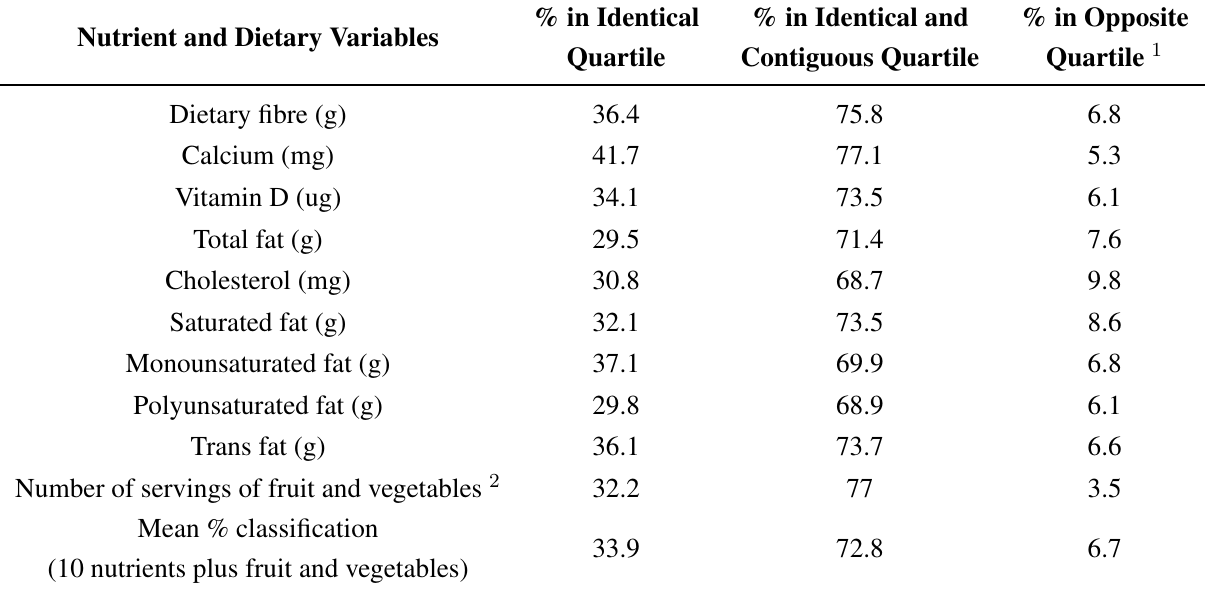
Table 4. Cross-classification of nutrient estimates from SDQ and mean of three non-consecutive 24HR, SDQ validation study ( n =